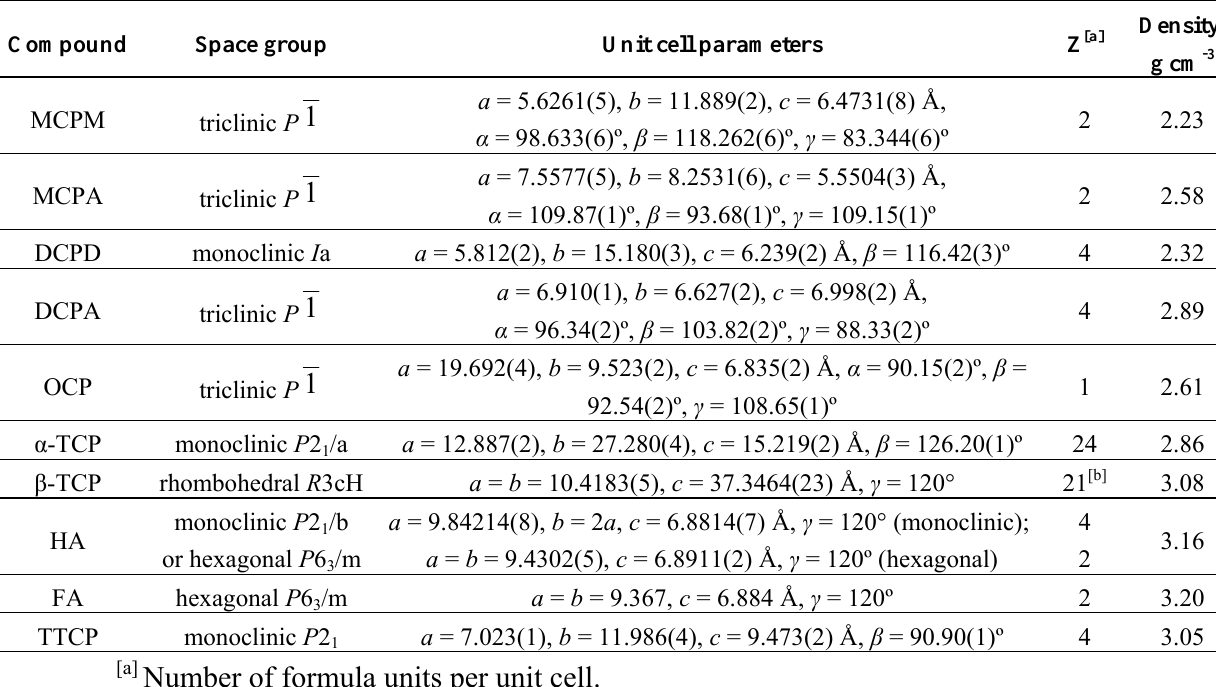
Table 3. Crystallographic data of calcium orthophosphates [14,73-75].